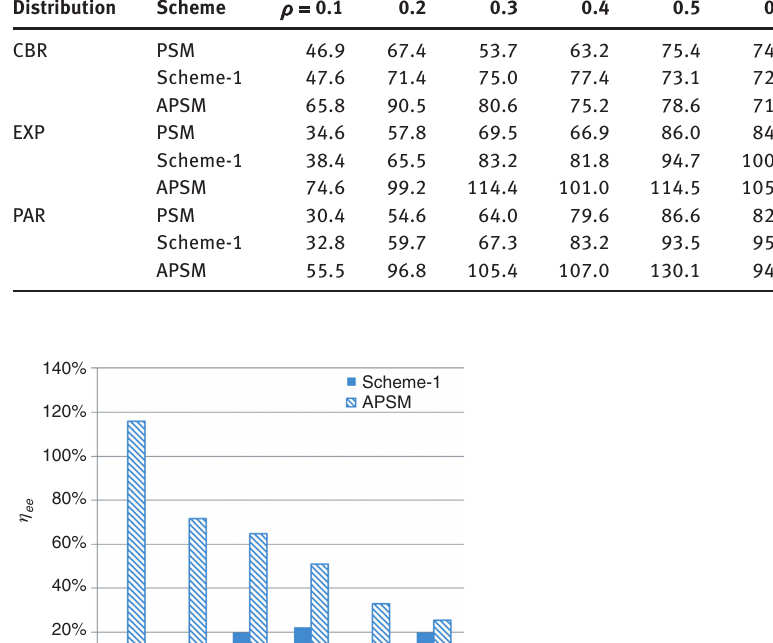
of the Three Schemes under Different Traffic Distributions (kb/J), When c = 3. Table 3. R ee Distribution